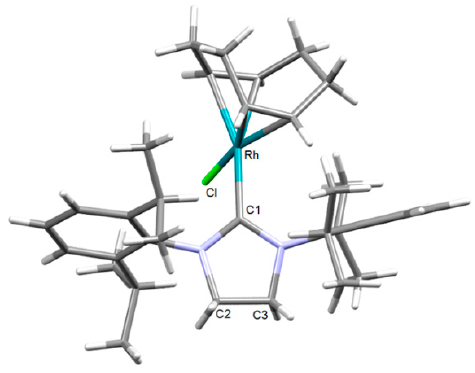
Figure 2. Capped sticks representation of the solid-state structure of [RhCl(cod)(SIPr)] ( 4 ) crystallized from CHCl 3 .